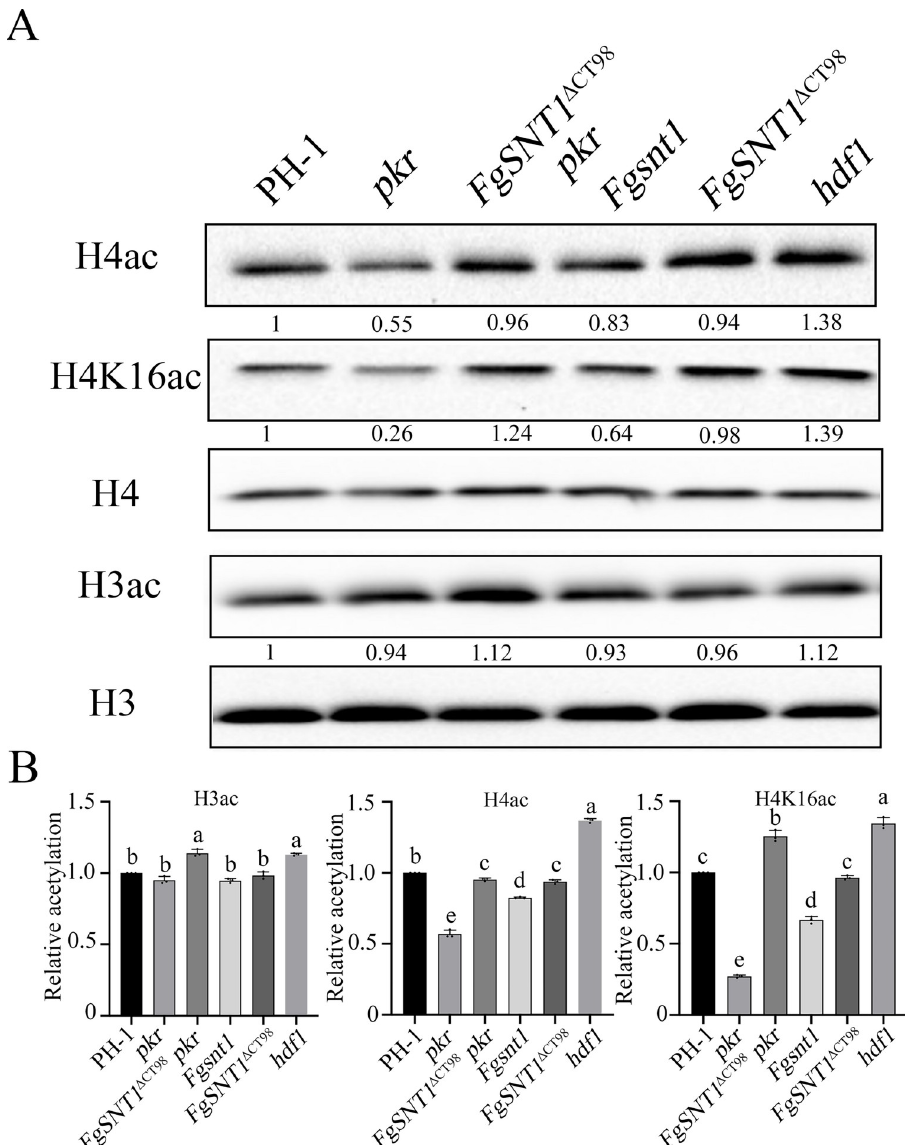
Fig 4. Deletion of the C-terminal region of FgSnt1 increases H4 acetylation in the pkr mutant. (A). Western blots of total proteins isolated from PH-1 and the pkr , FgSNT1 Δ CT98 pkr , Fgsnt1 , FgSNT1 Δ CT98 , and hdf1 mutants were detected with antibodies specific for H3ac, H4ac, and H4K16ac. Detection with anti-H3 and anti-H4 antibodies was used as a loading control. (B). Quantitative analysis of the histone acetylation level by calculating the ratio of the quantified acetylated and non-acetylated H3 and H4